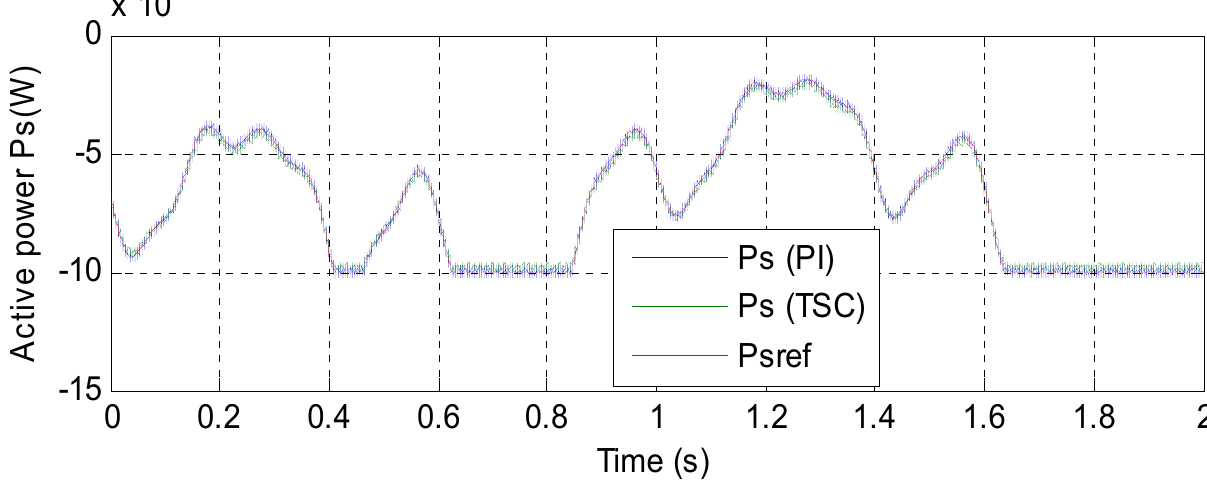
Figure 17. Active power.